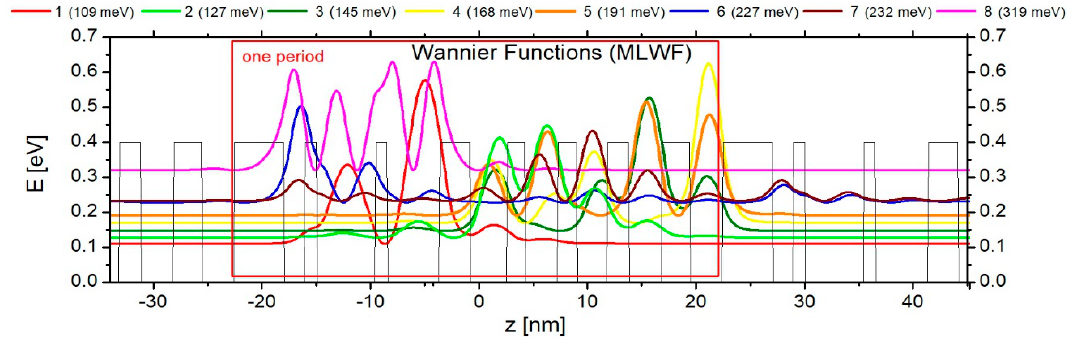
Figure 5. The base of MLWF calculated in a thermodynamic equilibrium for the structure no. 3. described in [3].